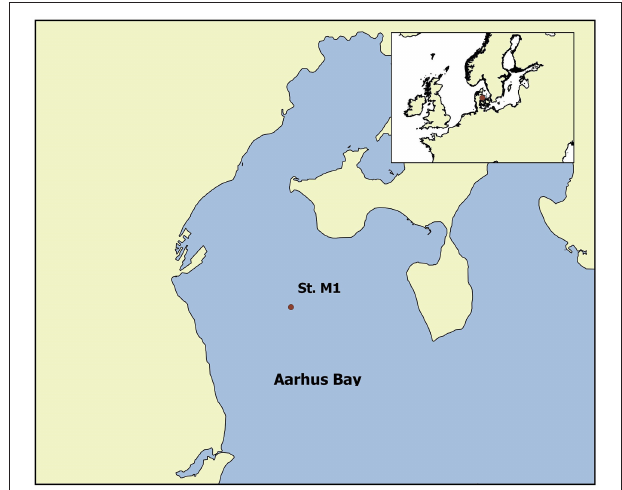
FIGURE 1 | Map of study site and location of Station M1 in Aarhus Bay,